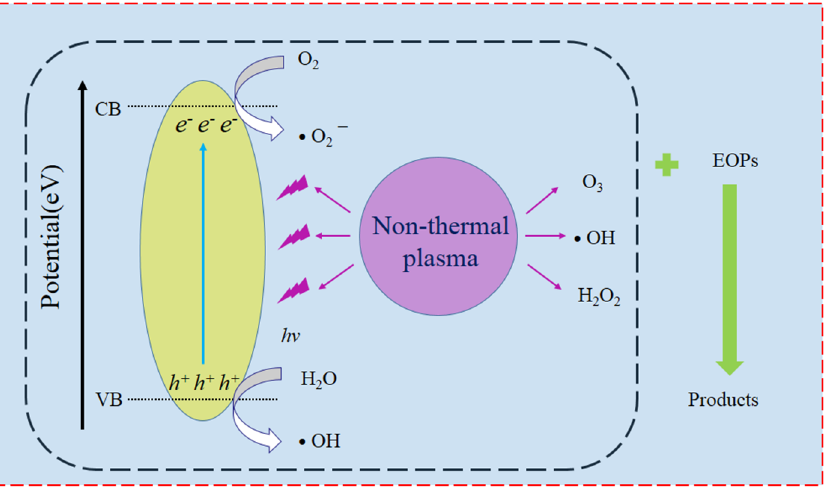
Figure 7. Possible degradation mechanisms of EOPs combined with heterogeneous catalyst.